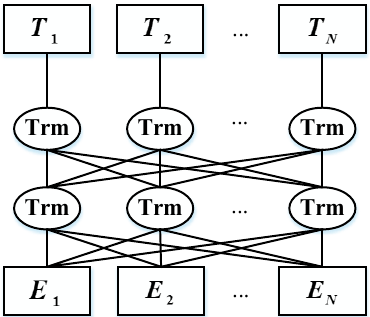
Figure 2. The structure of Bidirectional Encoder Representations from Transformers (BERT) Model.